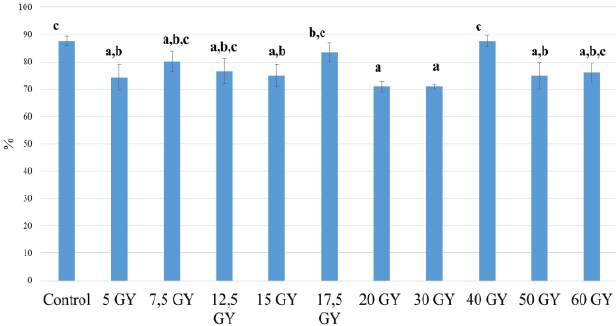
Figure 2 . Germination percentage of the plants at different doses of radiation. Legend: Different letters mean that there are significant differences between the measured characteristics at the level of α = 0.05 based on the TUKEY test. Different dosage of irradiation treatments showed high morphology heterogeneity ( Figure 7 ). A very unique and totally uniform treatment, the 17.5 Gray K2 was observed, whose morphology and growth habit significantly differed from the others. The same dose of irradiated seeds at other positions do not exhibit such